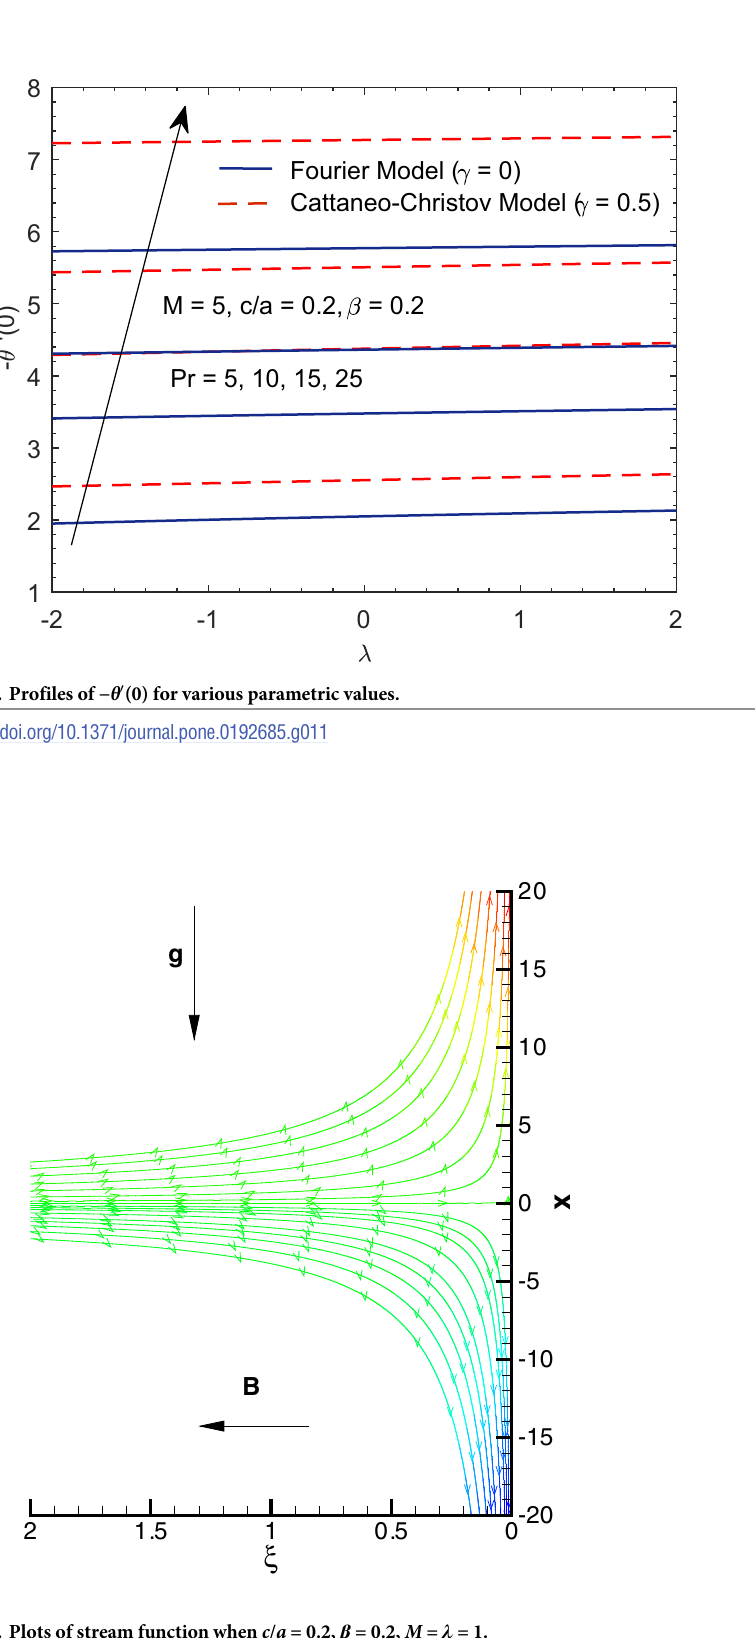
Fig 12. Plots of stream function when c / a = 0.2, β = 0.2, M = λ =